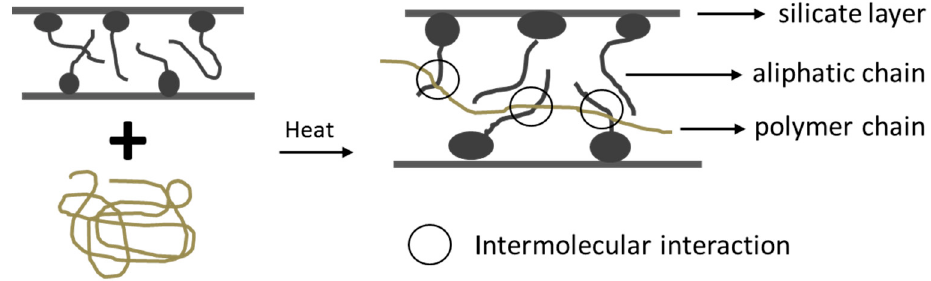
Figure 2. Melt intercalation synthesis of polymer/clay nanocomposite. Adapted from [27].